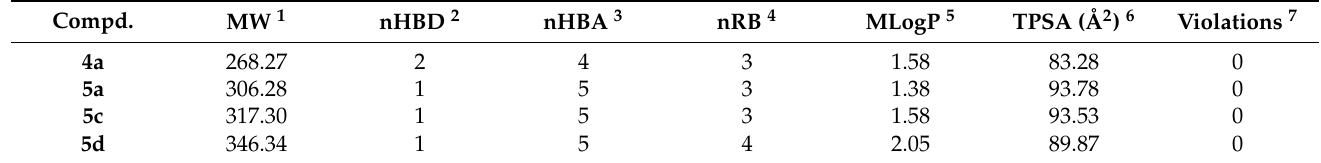
Table 5. Predicted physicochemical properties of the most active quinazolin-4(3 H )one derivatives 4a , 5a , 5c , and 5d